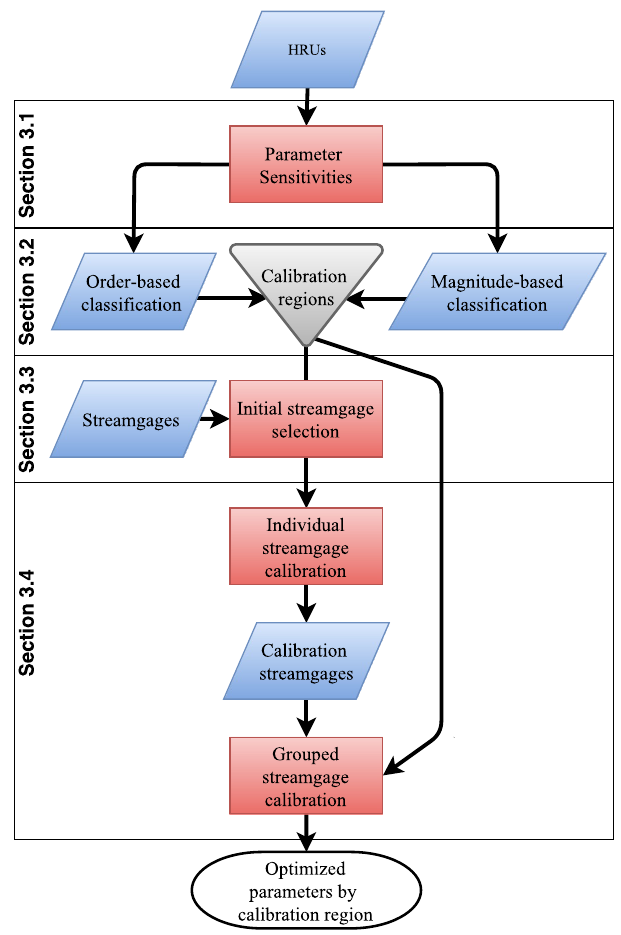
Figure 3. Schematic flowchart of the parameter regionalization pro- cedure described in Sect. 3: parameter sensitivities (Sect. 3.1), cal- ibration regions (Sect. 3.2), initial streamgage selection (Sect. 3.3), and grouped streamgage calibration (Sect.